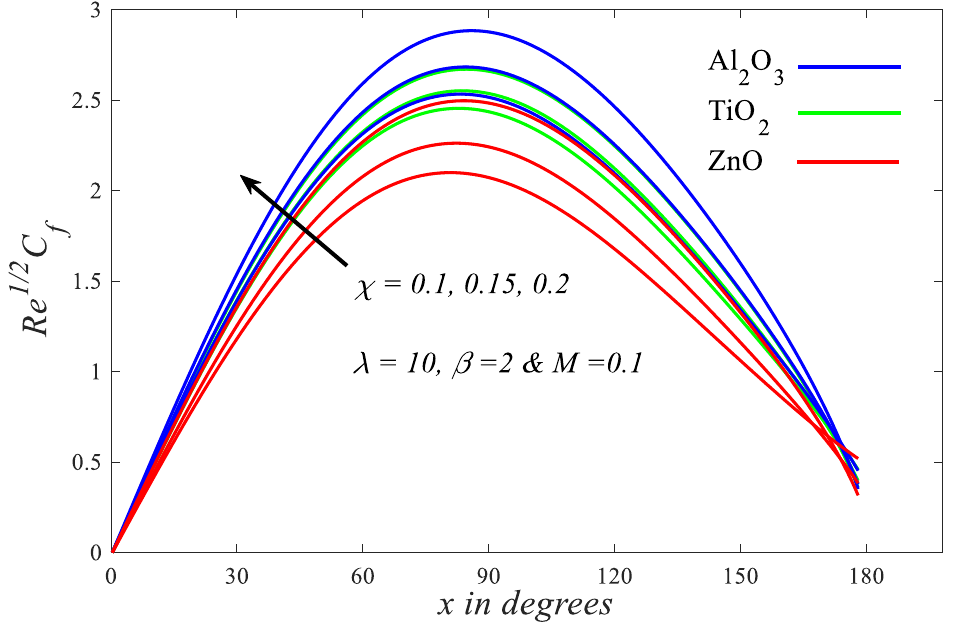
C . Figure 5. Impression of χ on Re 1/2 C f . Figure 5. Impression of  on 1/2 Re f The variation of Nusselt number and skin friction with the Casson parameter are shown in Figures 6 and 7, respectively. It can be seen that the Casson parameter has a positive effect on Nusselt number while it has a negative effect on skin friction. Physically, increasing the Casson parameter leads to a decrease in yield stress, which in turn reduces skin friction. At the same time, the higher values of the Casson parameter reduce the viscosity of the fluid, which contributes to an increase in heat transmission and, thus, an increase in the Nusselt number.